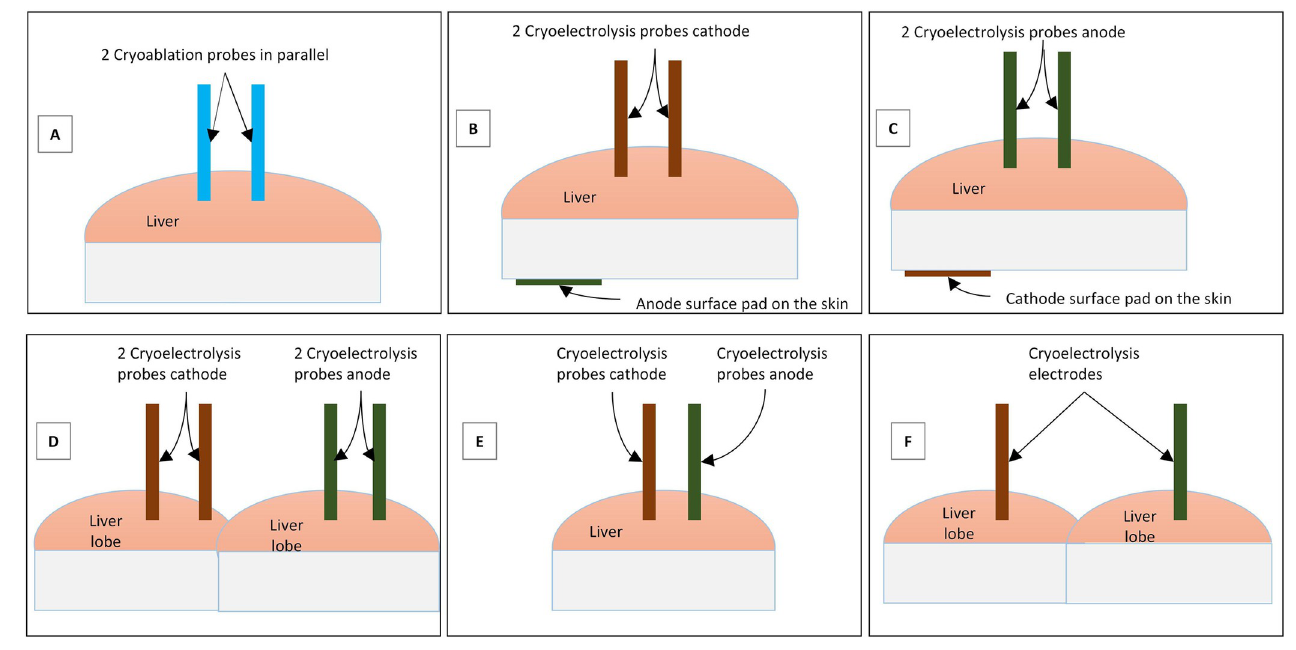
Fig 2. Cryoelectrodes configuration.